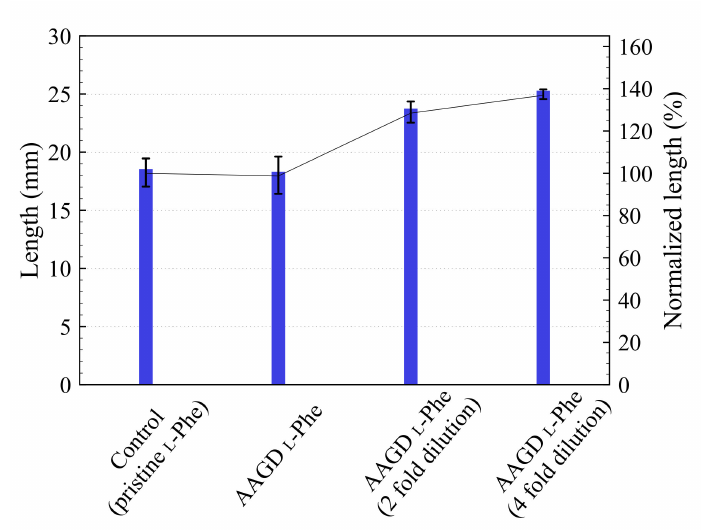
Figure 6. Plant-growth enhancement e ff ect on radish sprout cultured in varying concentrations of L -Phe treated with